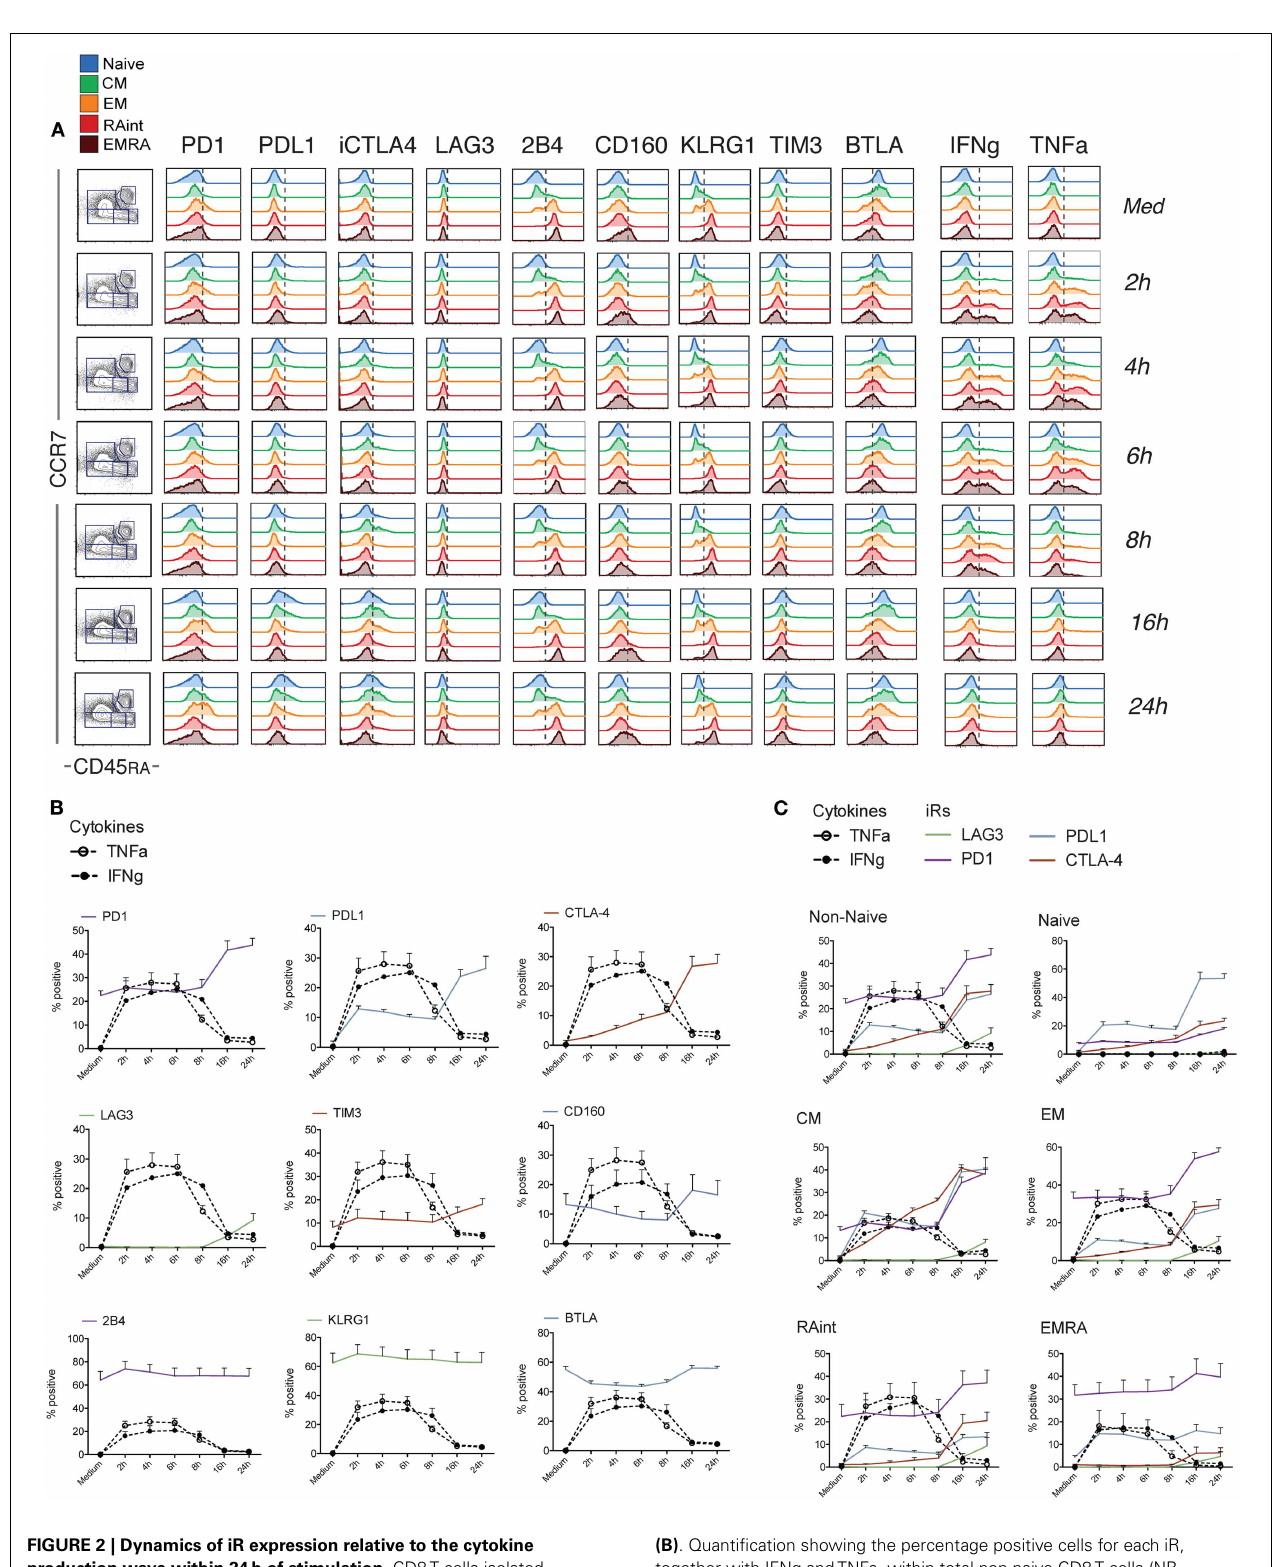
FIGURE 2 | Dynamics of iR expression relative to the cytokine production wave within 24h of stimulation . CD8T cells isolated from healthy donor PBMC were analyzed at different time-points after stimulation with anti-CD3 and anti-CD28 antibodies and analyzed for the various iRs together withTNFa and IFNg, as indicated ( N = 5). (A) . One representative example of the analysis, done as in Figure 1A .